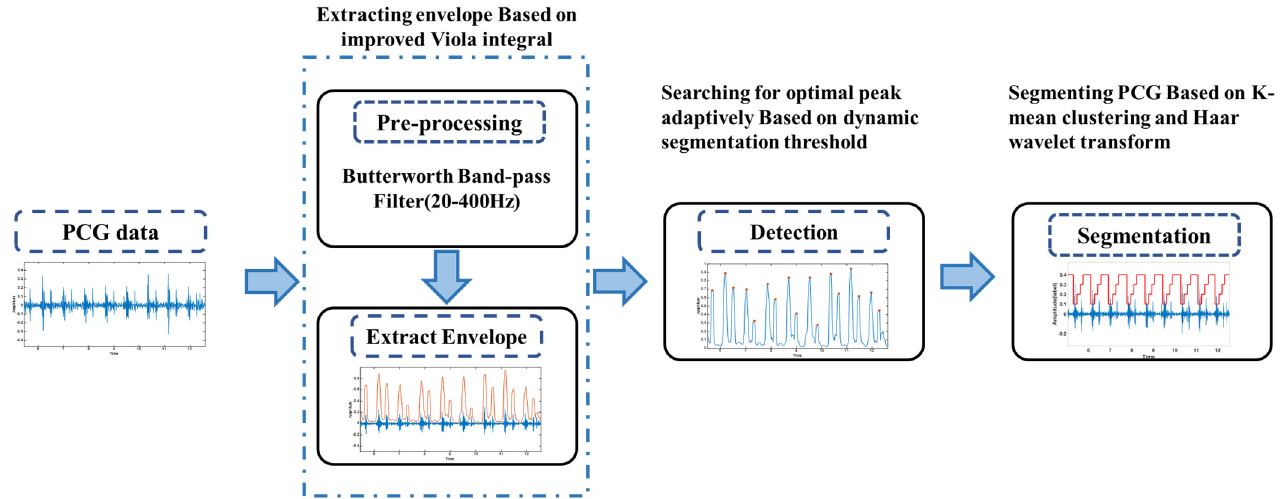
Figure 2. The proposed method framework for heart sound segmentation.